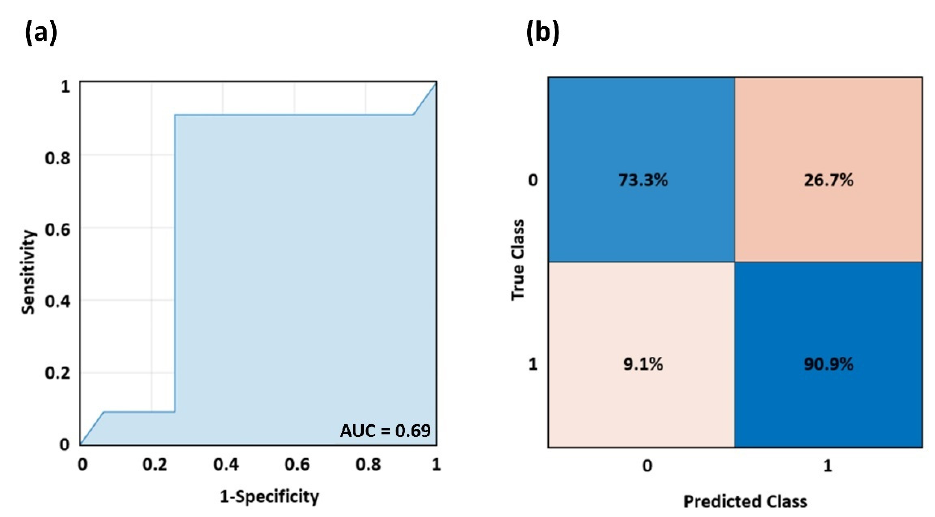
Figure 5. ( a ) ROC curve delivered by the cross-validated DTC when discriminating AD and HCs, and ( b ) associated confusion matrix.